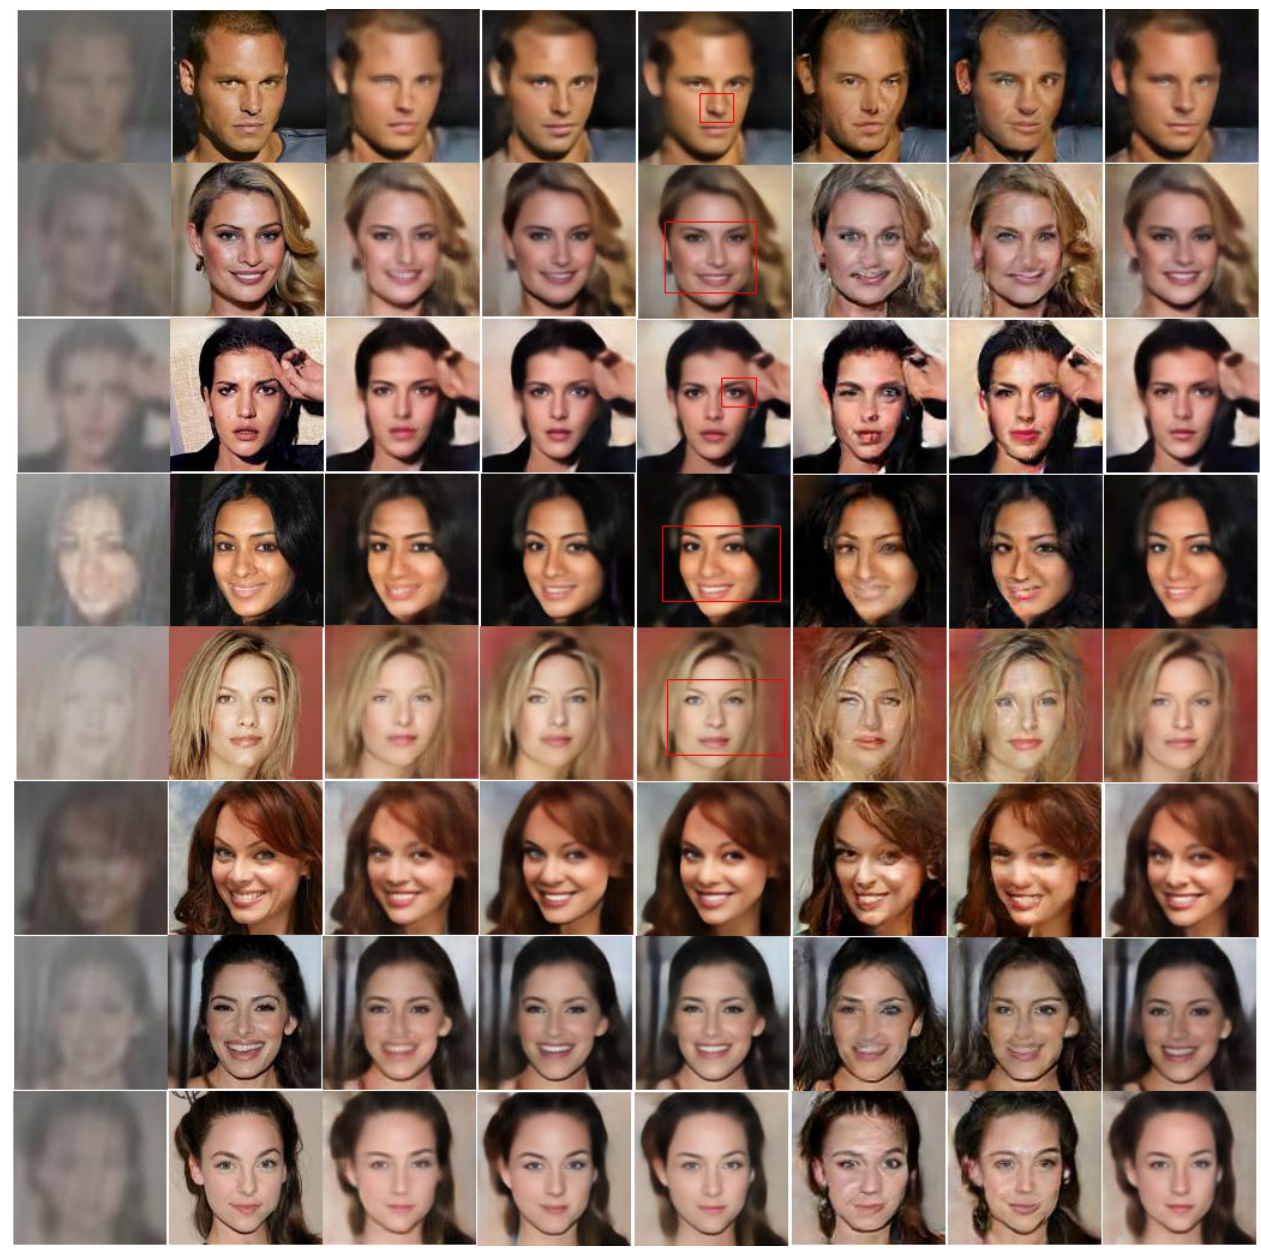
Figure 7. Results: input LRHR-FIs, ground truth HR-FIs, SRGAN [26], proposed method (HRRM + FPM + SRGAN), proposed method (HRRM + FPM + FCG-GAN), heavy rain removal [8], pix2pix [43], and face SR [31] (left to right).